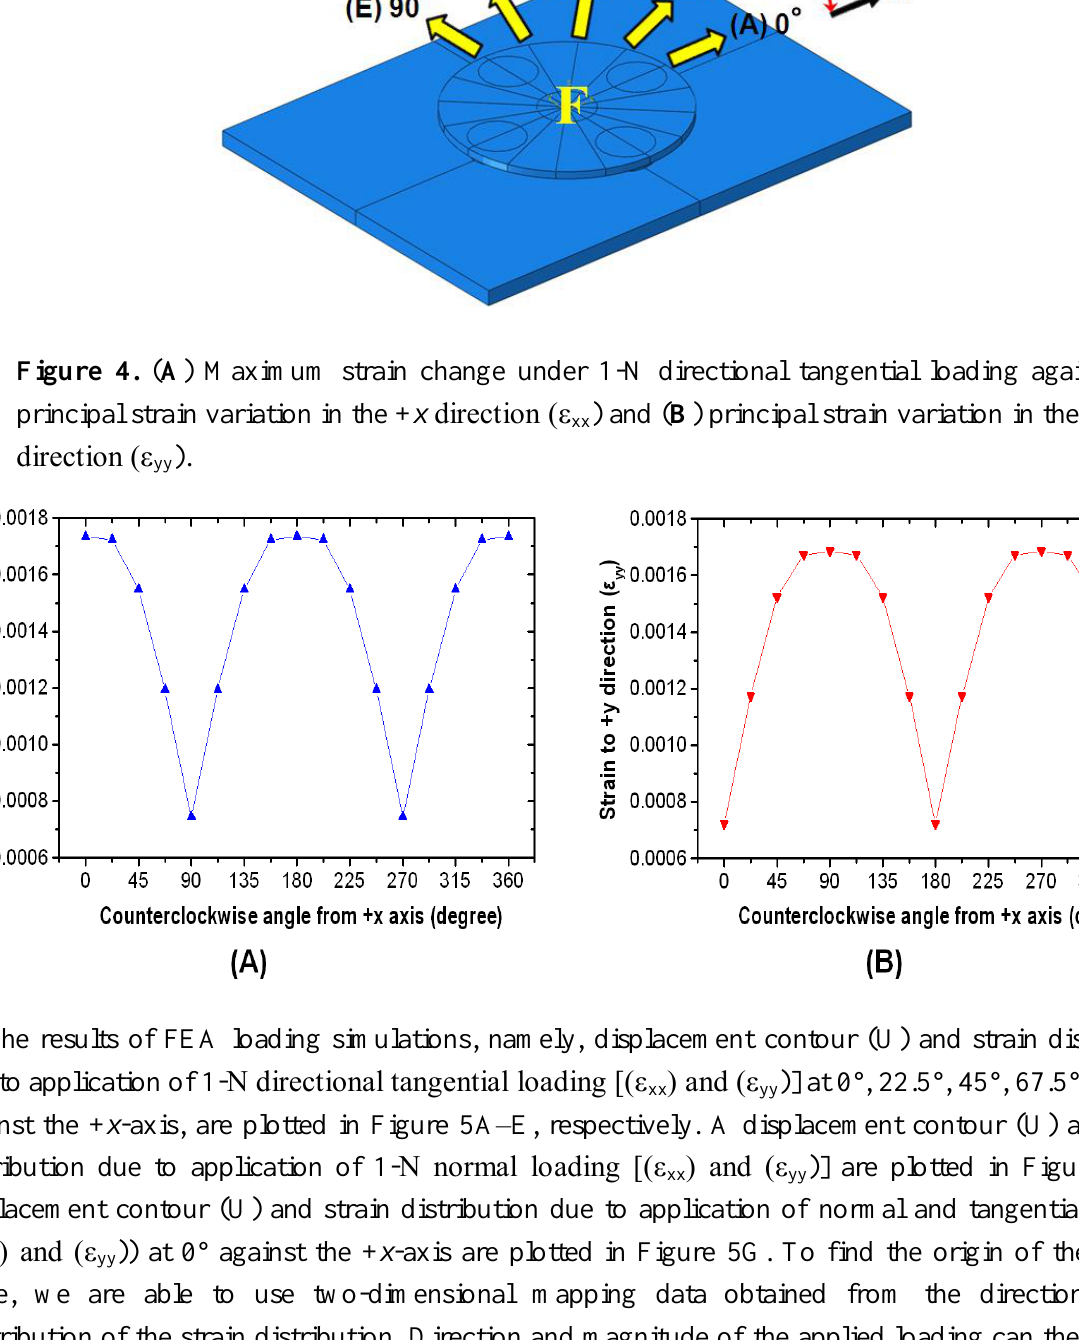
Figure 3. Schematic representation of the design of loading simulations for each directional tangential loading.